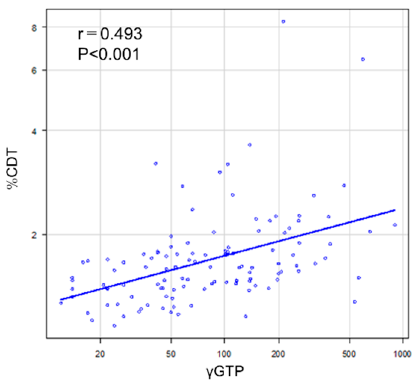
Figure 3. Correlation between serum carbohydrate-deficient transferrin and gammaglutamyl trans- ferase levels.